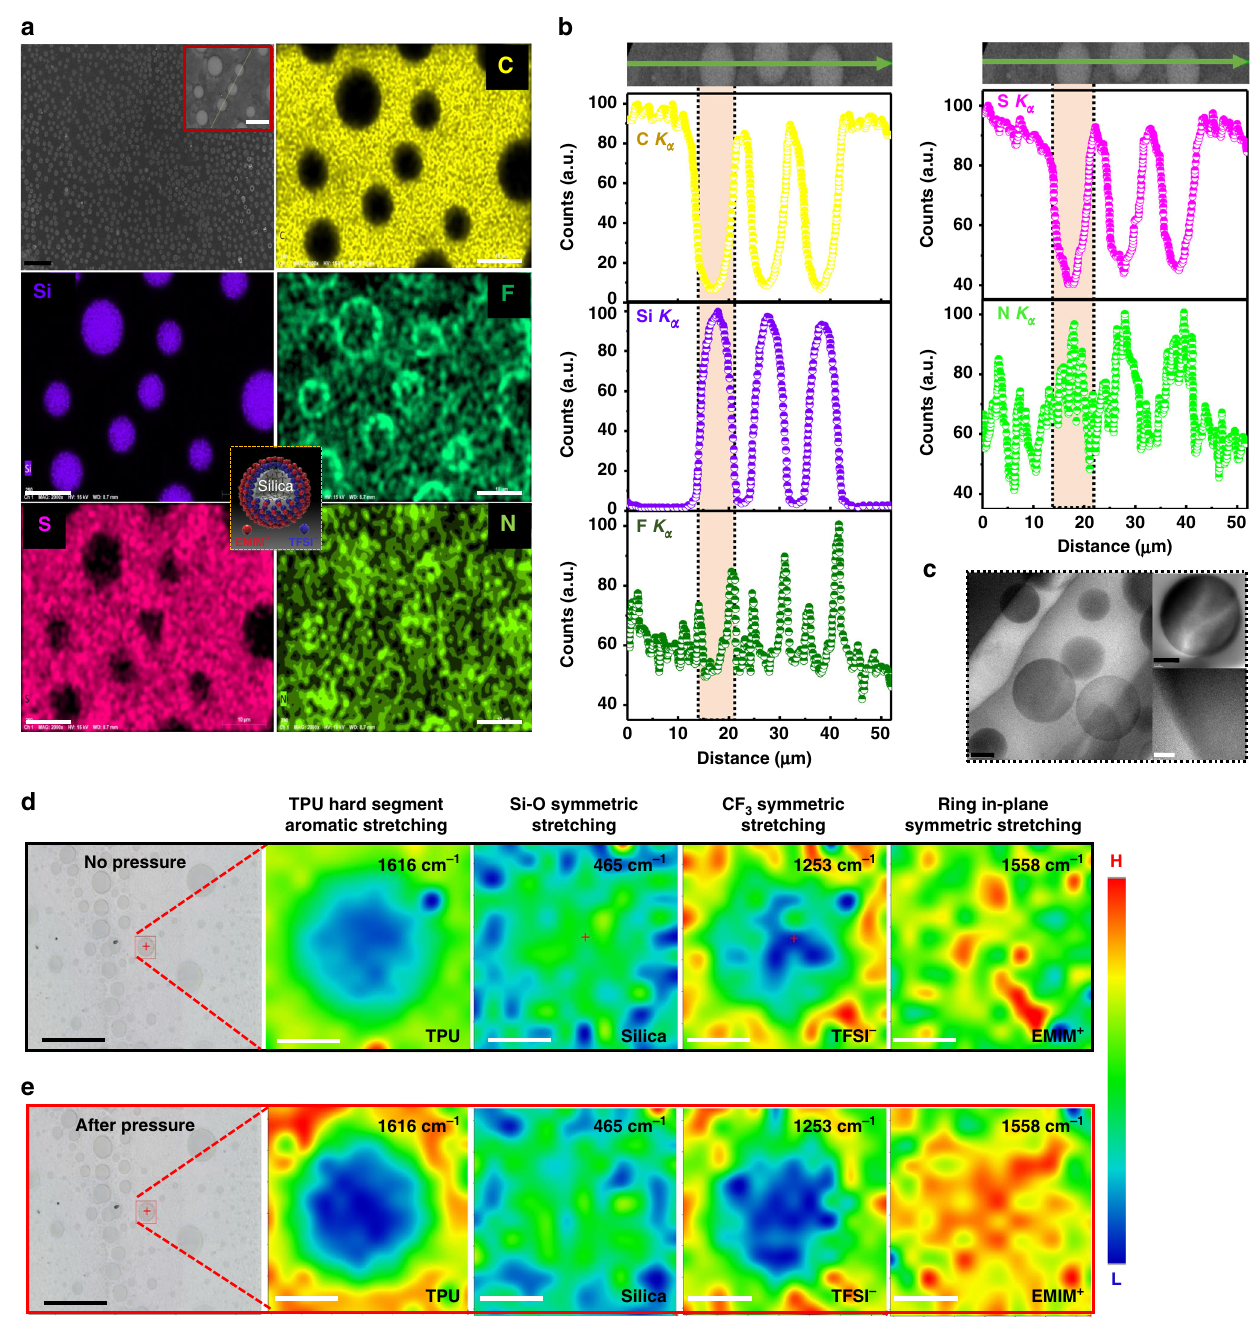
Fig. 2 Morphological characterization of IL(20 wt%) – silica – TPU SMHIP. a FE-SEM image and EDX-elemental maps (corresponding to FE-SEM image shown in inset, red box) for C, Si, F, S, and N. Scale bars, 20 µ m (black); 10 µ m (white). Inset in the middle (yellow box) illustrates the microscopic arti fi cial plasma membrane structure consisting of ordered stepwise layers of TFSI − and EMIM + on silica microspheres. b EDX line scan pro fi les for C ( K α ), Si ( K α ), F ( K α ), S ( K α ), and N ( K α ) along the noted path (green arrow, inset). The x -axis represents the distance along the scan line (green arrow) and y -axis represents the relative elemental count along the scan line. Relatively higher intensity of F and S (coming from TFSI − ) at the circumferential region of silica structures and relatively high intensity of N (coming from TFSI − , EMIM + , and TPU collectively) at the center of the silica microspheres observed in elemental maps and line scans establish a microscopic arti fi cial plasma membrane structure consisting of ordered stepwise layers of TFSI − and EMIM + on silica microspheres (Fig. 2a, middle inset, where gray sphere represents silica microstructures, blue anions represent TFSI − ions, and red cations represent EMIM + ions). c TEM and HR-TEM images. Scale bars, 0.5 µ m (black); 20 nm (white) d Raman intensity maps (before external pressure) corresponding to marked area (red box) in optical microscopy image at 1616 cm − 1 (aromatic stretching of TPU hard segment), 465 cm − 1 (Si – O symmetric stretching of silica matrix), 1253 cm − 1 (SO 2 asymmetrical stretching and CF 3 symmetrical stretching of TFSI − anion), 1558 cm − 1 (ring in plane symmetrical stretching, CH 3 (N) stretching, CH 2 (N) stretching of EMIM + cation); the color bar represents Raman intensity pro fi le (H — highest and L — lowest). e Raman intensity maps obtained after ten repeated loading/unloading cycles of external pressure applied by thumb on i(20) – silica – TPU SMHIP fi lm. Scale bars, 100 µ m (black); 10 µ m